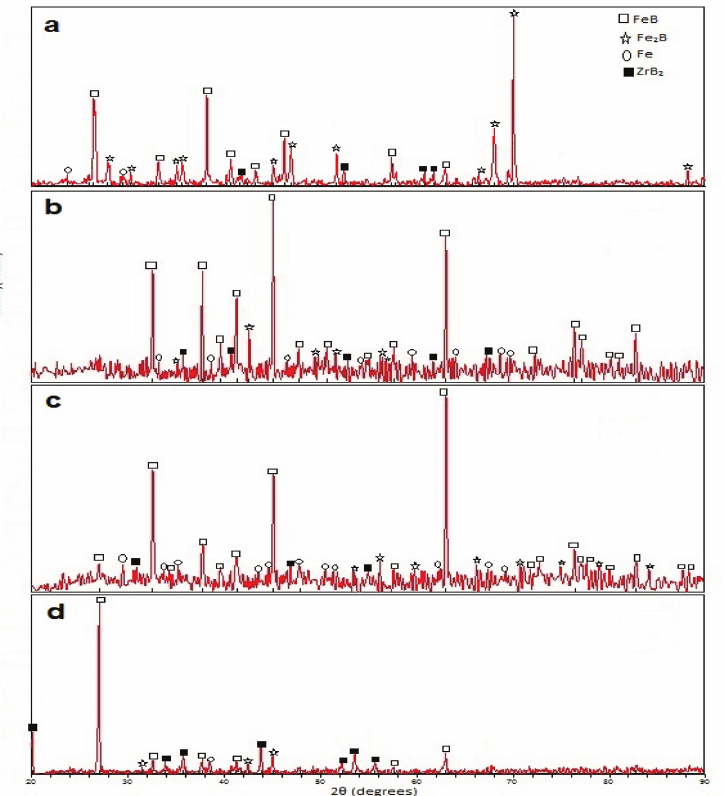
Figure 2: X-ray diffraction patterns obtained from the surface of pure Fe borided at 1,173 K for 4 h using (a) ZB1, (b) ZB2, (c) ZB3 and (d) ZB4